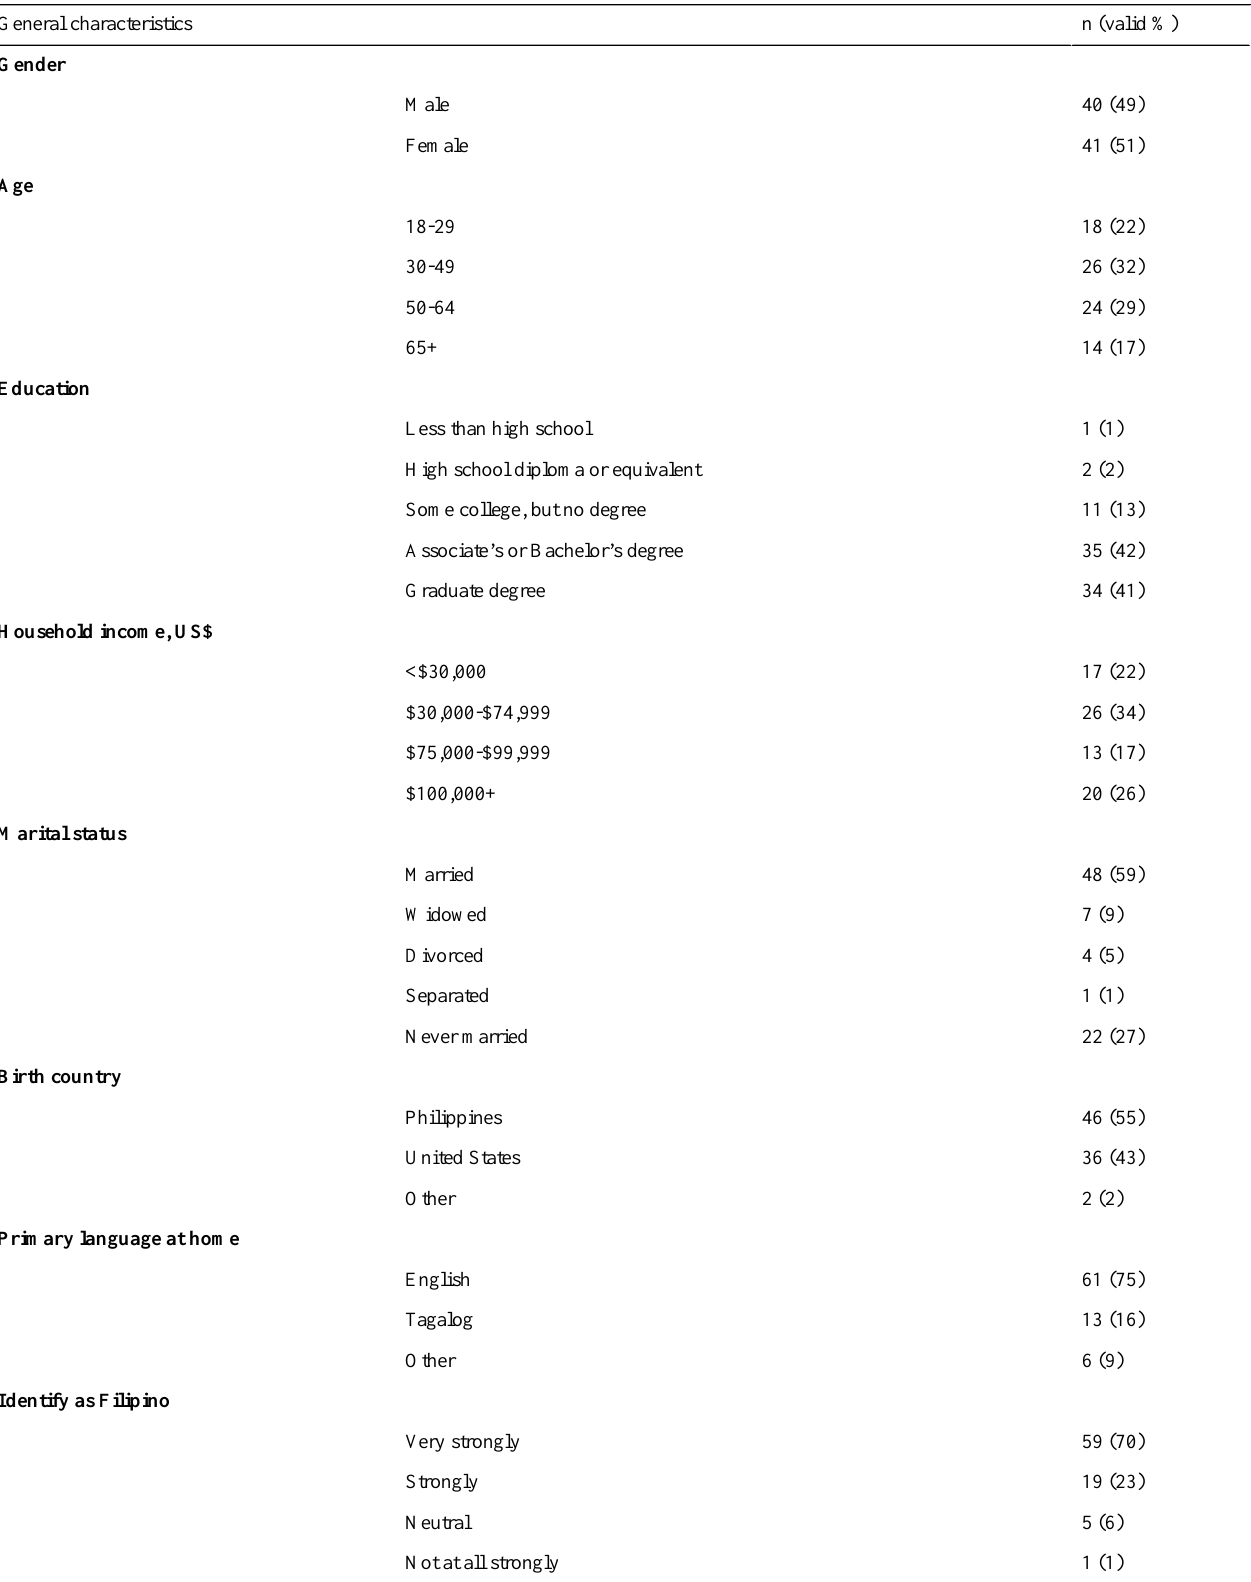
Table 2. Study 1 demographic characteristics